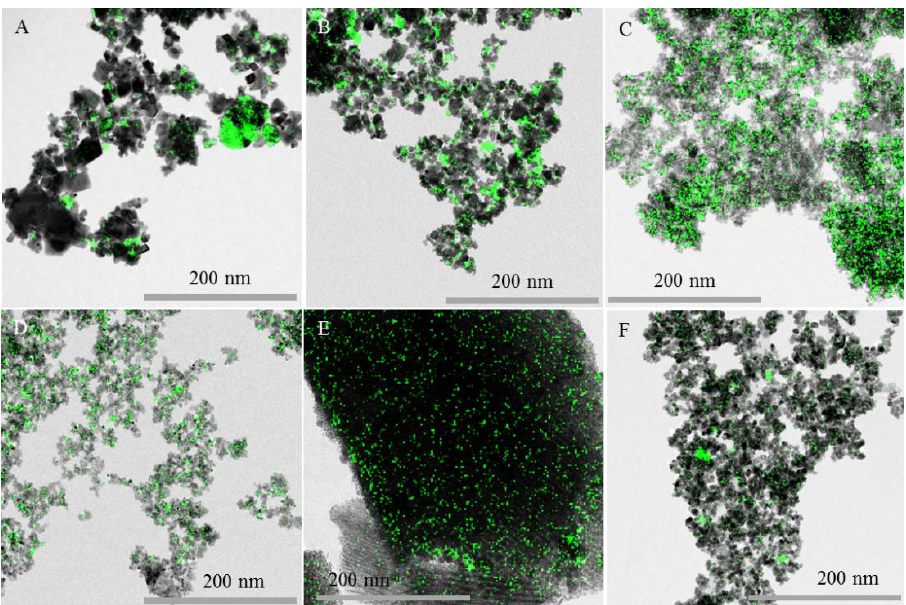
Figure 5. TEM-EELS images of ( A ) Ni/CeO 2 , ( B ) Ni/CeO 2 -CA, ( C ) Ni/Al 2 O 3 -CA, ( D ) Ni/SiO 2 -CA, ( E ) Ni/SBA-15-CA and ( F ) spent Ni/CeO 2 -CA catalysts.